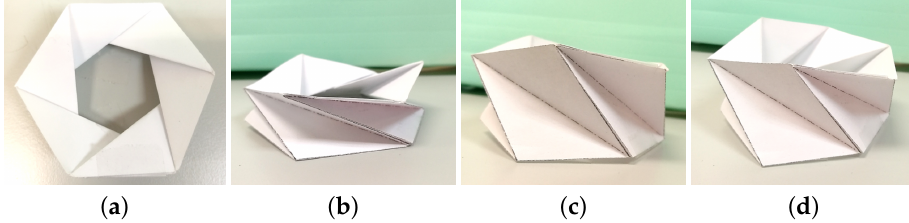
Figure 2. Cylinder polyhedron origami with one section ( h 1 ) and six faces ( n = 6). ( a ) Top view collapsed state. ( b – d ) Folding state.